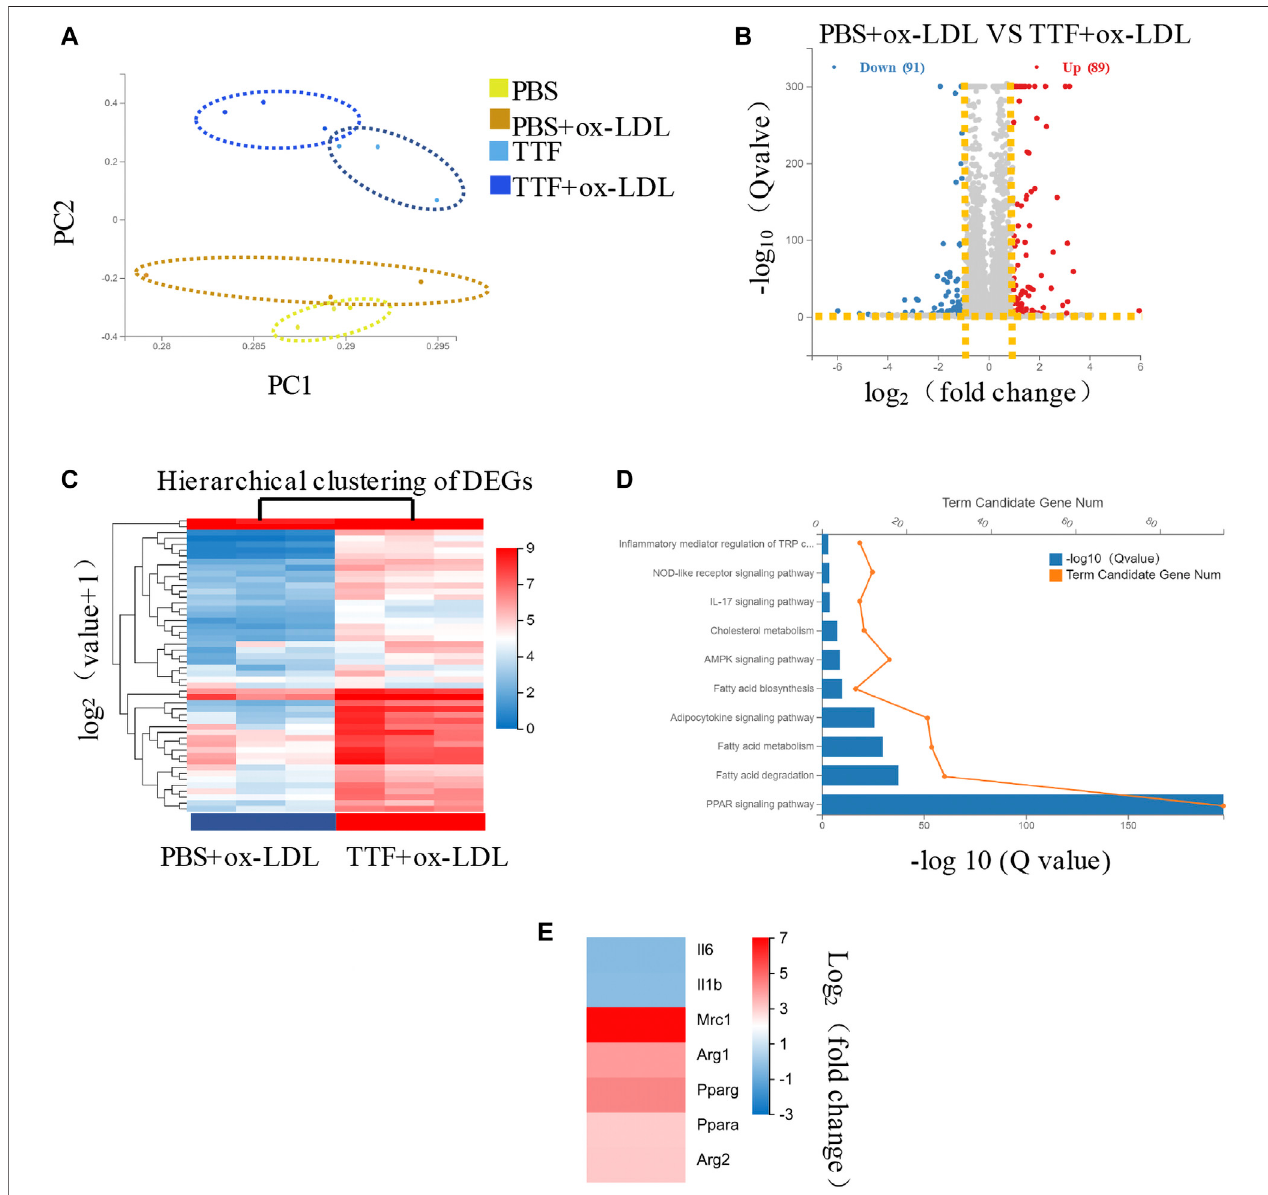
FIGURE 7 | RNA-seq of PM in ApoE -/- mice (A) Principal component analysis showed the overall transcriptomic similarity of the four groups (B) Differential expression analysis revealed induced by ox-LDL, TTF treatment in macrophages. Volcano plots show the differentially expressed genes (DEGs; fold change > 2 or < − 2, false discovery rate adjusted p value < 0.05) in macrophages (C) Hierarchicalclusteringofquantitativegenesexpressionpro fi lingformacrophagesofPBS+ox-LDLandTTF+ox-LDLgroups (D) KEGGpathwayanalysisofDEGs betweenPBS+ox-LDLandTTF+ox-LDLgroups (E) SelectedgenesinvolvedinmacrophagepolarizationbetweenTTF+ox-LDLandPBS+ox-LDLgroupsareshown as a heatmap.